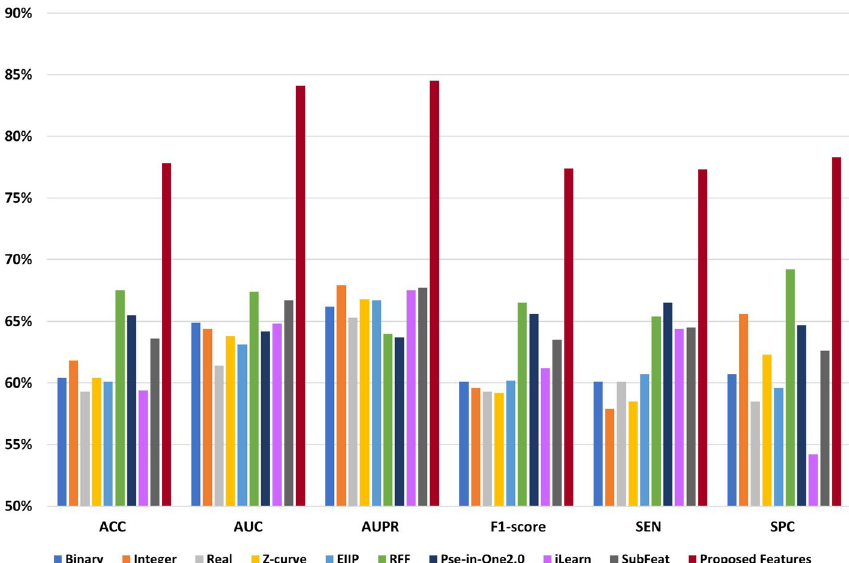
Figure 3. The performance evaluation of the features based on PyFeat with AB compared with other techniques: five numerical representations, RFF, Pse-in-One2.0, iLearn, and SubFeat based on the lncRNA